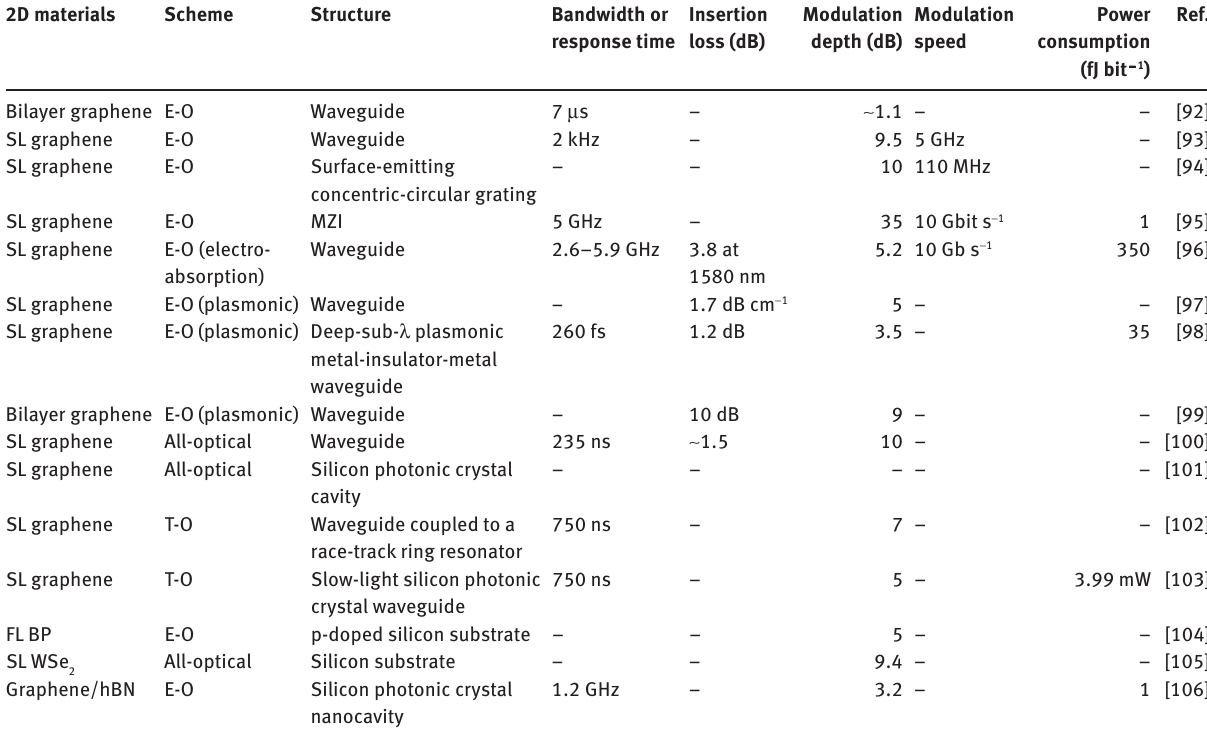
Table 2: Reported works of electro-optical (E-O), all-optical, and thermo-optical (T-O)